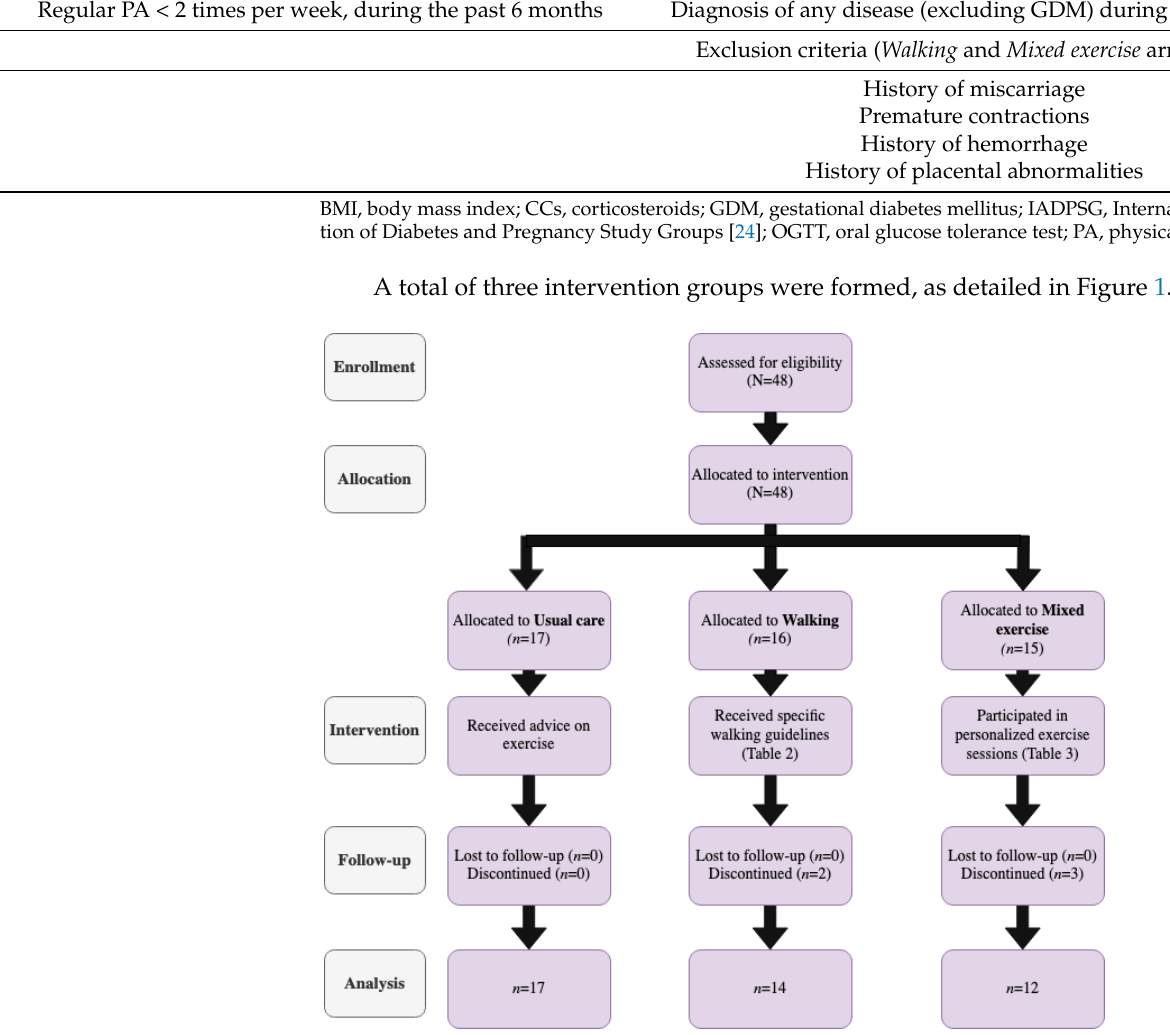
Figure 1. TREND [23] diagram of the study’s process.